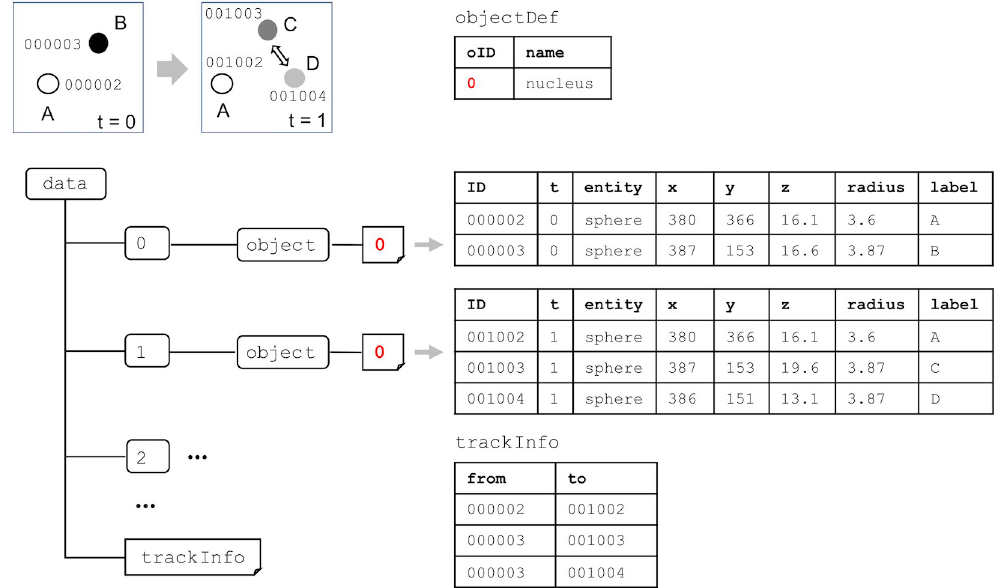
Fig 2. An example of the description of the spatiotemporal information of biological objects and their tracking information. The dataset name in object group corresponds to the identifier (ID) of the biological object (red). Each row in the dataset must have a unique ID and its spatiotemporal information. A label can optionally be attached for each object. The tracking information including object divisions and fusions can be stored in trackInfo dataset.